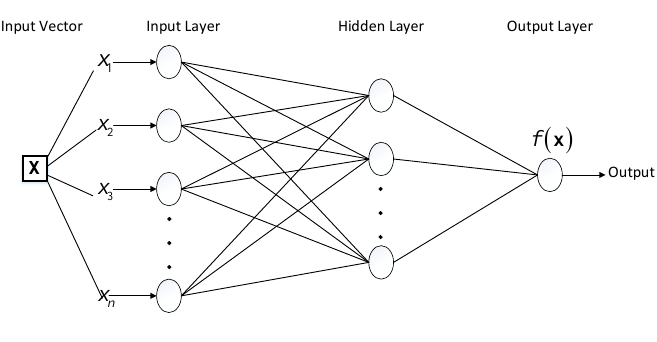
Figure 1. Schematic diagram of an ANN.